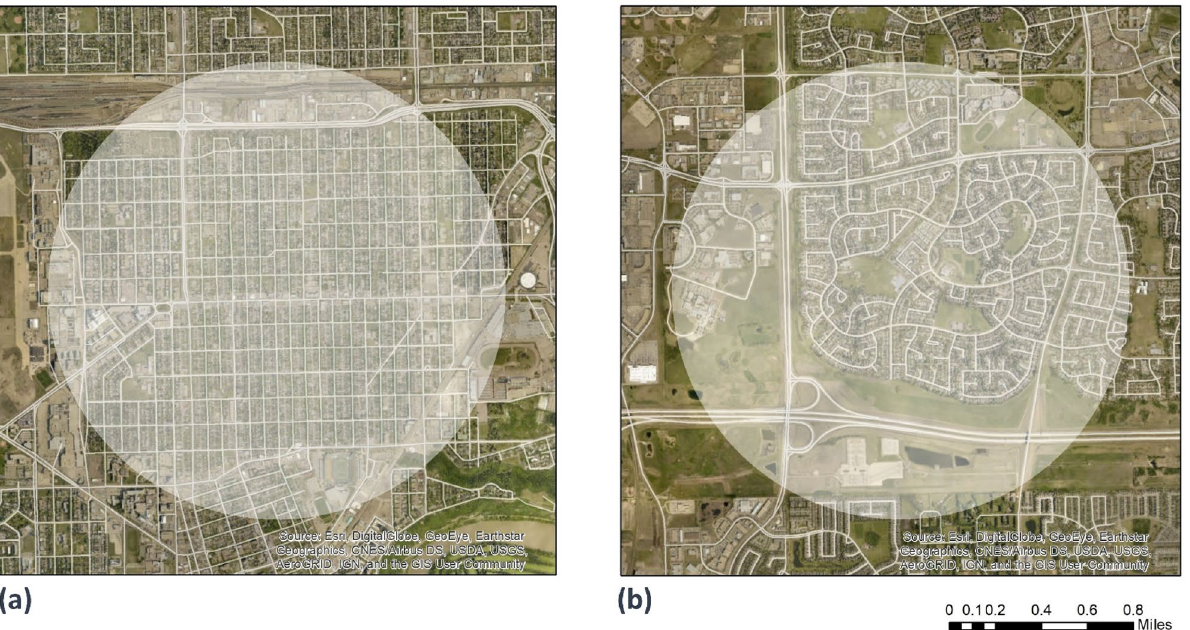
Figure 2. Examples of neighbourhood buffers with ( a ) high street integration (score = 299) and ( b ) low street integration (score = 176) (Imagery Source: Esri, DigitalGlobe, GeoEye, Earthstar Geographics, CNES/Airbus DS, USDA, USGS, AeroGRID, IGN, and the GIS User Community. Figure generated using ArcMap Version